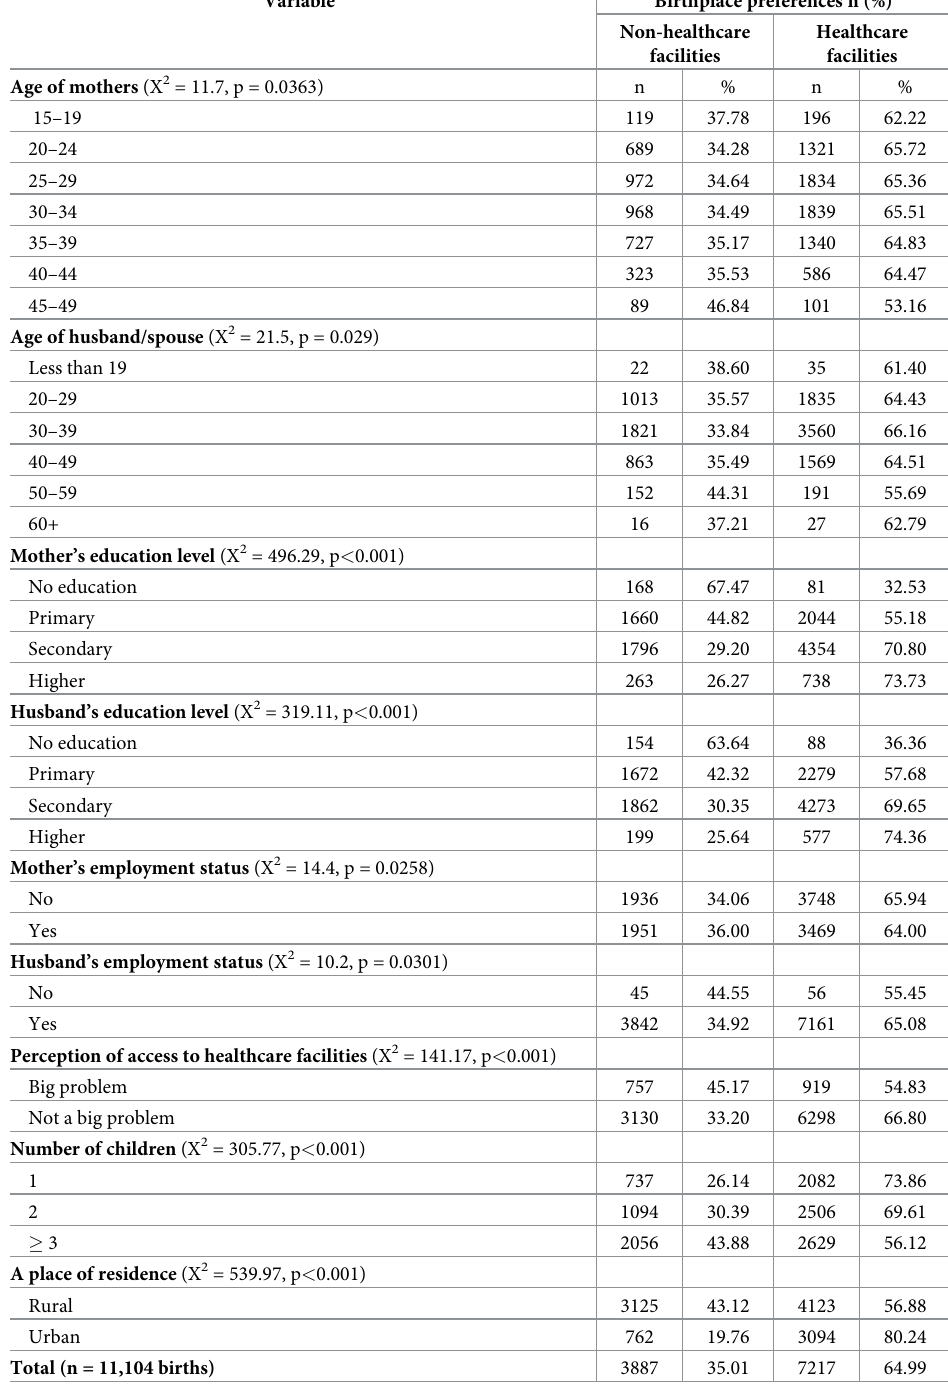
Table 1. Demographic characteristics and birthplace preferences (N =